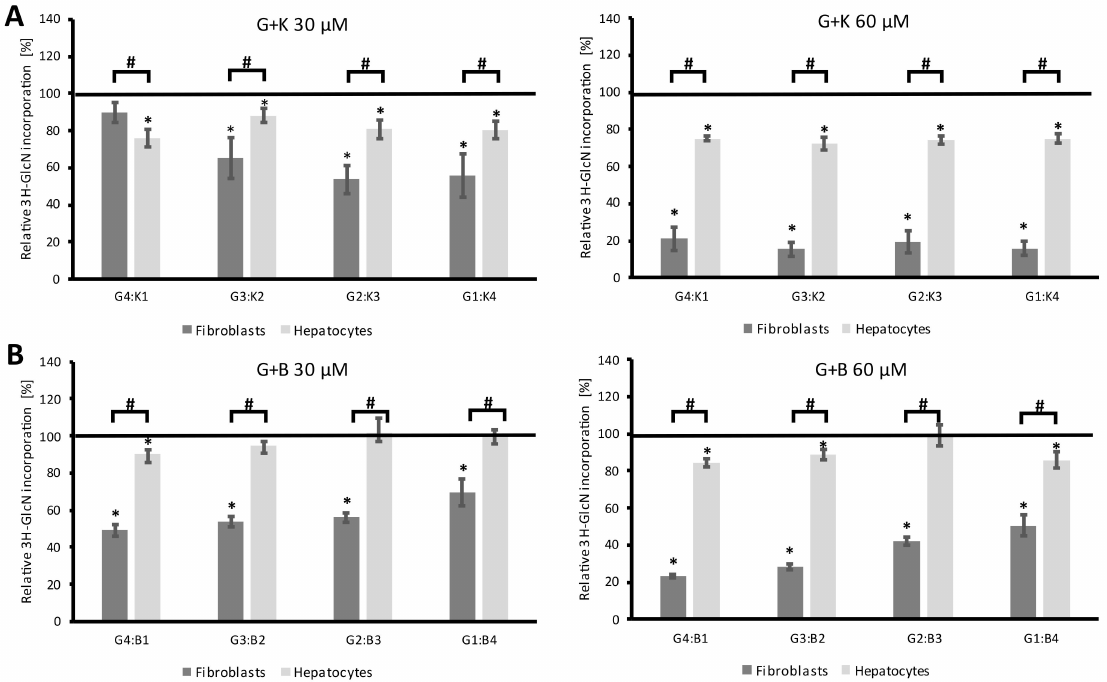
Figure 6. The level of GAG synthesis in fibroblasts and primary hepatocytes after 48 h of exposure to flavonoids in two-component mixtures: genistein and kaempferol ( A ), and genistein and biochanin A ( B ) at final concentrations of 30 µ M and 60 µ M, respectively, measured by the D-[1-3H]-glucosamine incorporation assay. The black line (100%) corresponds to metabolic activity in control cells treated with 0.05% DMSO. Bars represent the average ± SD obtained for two different cell cultures from two different experiments. An asterisk (*) indicates statistically significant differences from control cells (ANOVA with Tukey’s post hoc, p < 0.05); hashtag (#) indicates statistically significant